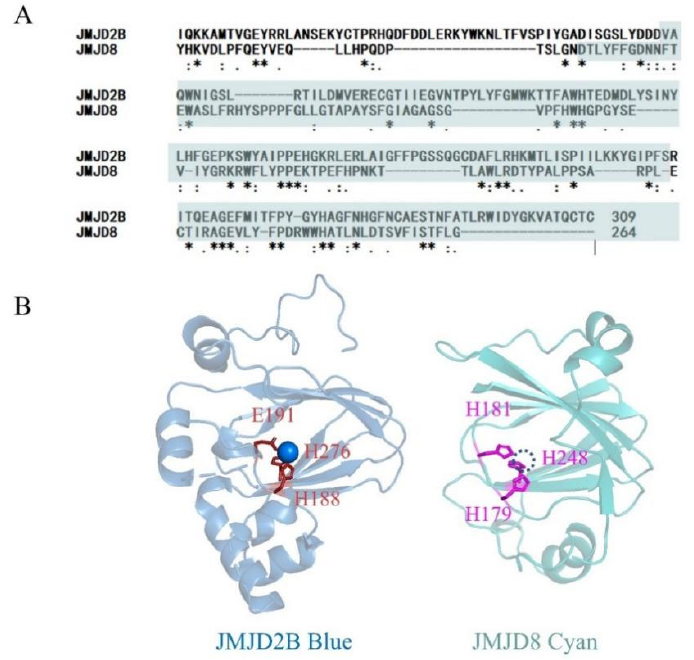
Figure 5. Sequence alignment and structural superimposition of JmjC domain of JMJD8 with JMJD2B. ( A ) Sequence alignment of JMJD2B and JMJD8 by Clustal Omega. JmjC domain is highlighted in cyan. An * (asterisk) indicates positions which have a single, fully conserved residue. ** indicates positions which have two fully conserved residues. *** indicates positions which have three fully conserved residues. A : (colon) indicates conservation between groups of strongly similar properties. A . (period) indicates conservation between groups of weakly similar properties. ( B ) Structural superimposition of JmjC domain of JMJD8 (AlphaFold: AF-Q96S16-F1) with JMJD2B(PDB:7JM5). The JMJD8 is shown as cyan carbon atoms. The JMJD2B is shown as blue carbon atoms with a blue Ni(II). Ni(II) is used to substitute Fe(II) in the crystal of JMJD2B.